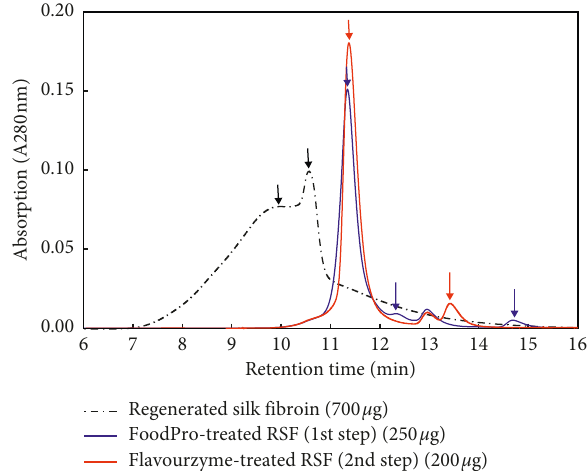
Figure 4: UV-visible spectra of regenerated fibroin and its en- zymatic hydrolysates obtained using FoodPro in the 1st step and Flavourzyme in the 2nd step.